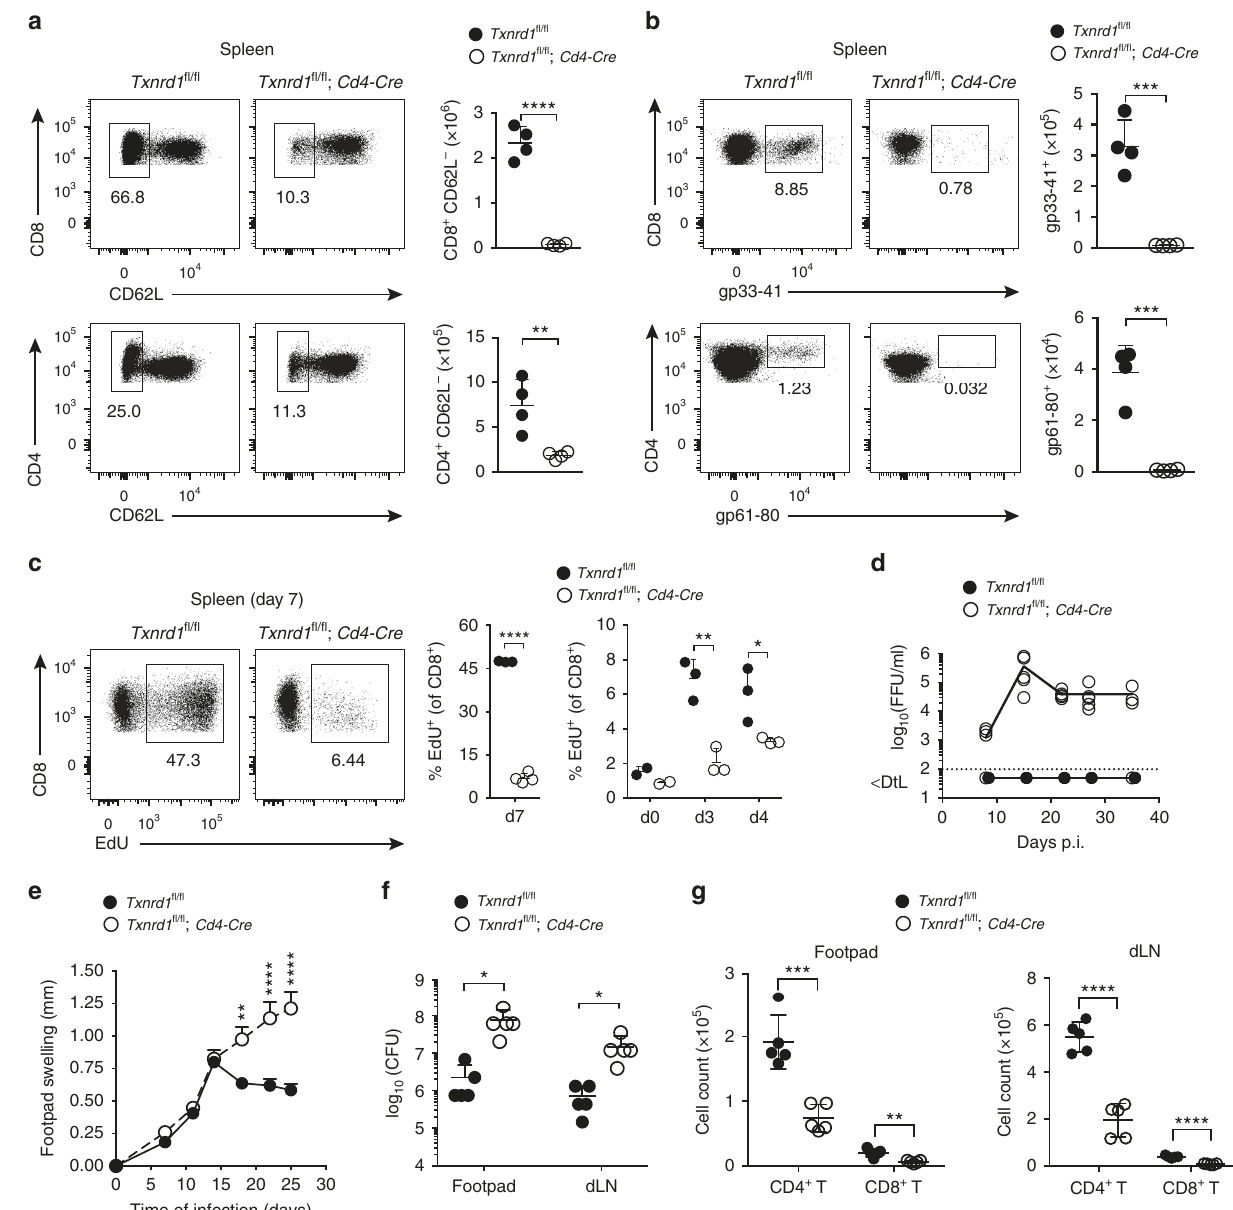
Fig. 3 Txnrd1 -de fi cient T cells fail to expand following viral and parasite infection. a – c Txnrd1 fl / fl and Txnrd1 fl / fl ; Cd4-Cre mice were infected i.v. with 200 focus-forming units (FFU) LCMV WE. a , b On day 7 of infection, activation of CD4 + and CD8 + T cells was assessed by downregulation of CD62L ( a ), and virus-speci fi c T cells were stained with gp 33 – 41 and gp 61 – 80 tetramers ( b ). c Proliferation of CD8 + T cells was assessed by EdU incorporation in spleens of LCMV-infected mice at the indicated days of infection. d LCMV titers over time were determined by focus assay of blood from mice infected with 500 FFU LCMV WE i.v. at indicated times after infection. Dotted line represents the detection limit (DtL; n = 5). e – g Txnrd1 fl / fl and Txnrd1 fl / fl ; Cd4-Cre mice were inoculated with 2 millions L . major promastigotes into the right and left hind footpad. e Footpad swelling. f Parasite load in infected footpads and dLNs 25 days after infection. g Total number of activated (CD62L − CD44 + ) CD4 + and CD8 + T cells in footpads (left) and dLNs (right) 25 days after infection. Means + standard deviations and + standard error of the mean are shown for a – c , f , g , and for e , respectively. Data are representative of two independent experiments ( a – g ). Student ’ s t test (two-tailed, unpaired) was used to compare Txnrd1 fl / fl and Txnrd1 fl / fl ; Cd4-Cre groups ( a – c , f , g ): * P ≤ 0.05; ** P ≤ 0.01; *** P ≤ 0.001; **** P ≤ 0.0001. Two-way ANOVA adjusted by Bonferroni ’ s multiple comparison test was used to compare Txnrd1 fl / fl and Txnrd1 fl / fl ; Cd4-Cre groups in e : ** P ≤ 0.0021; **** P ≤